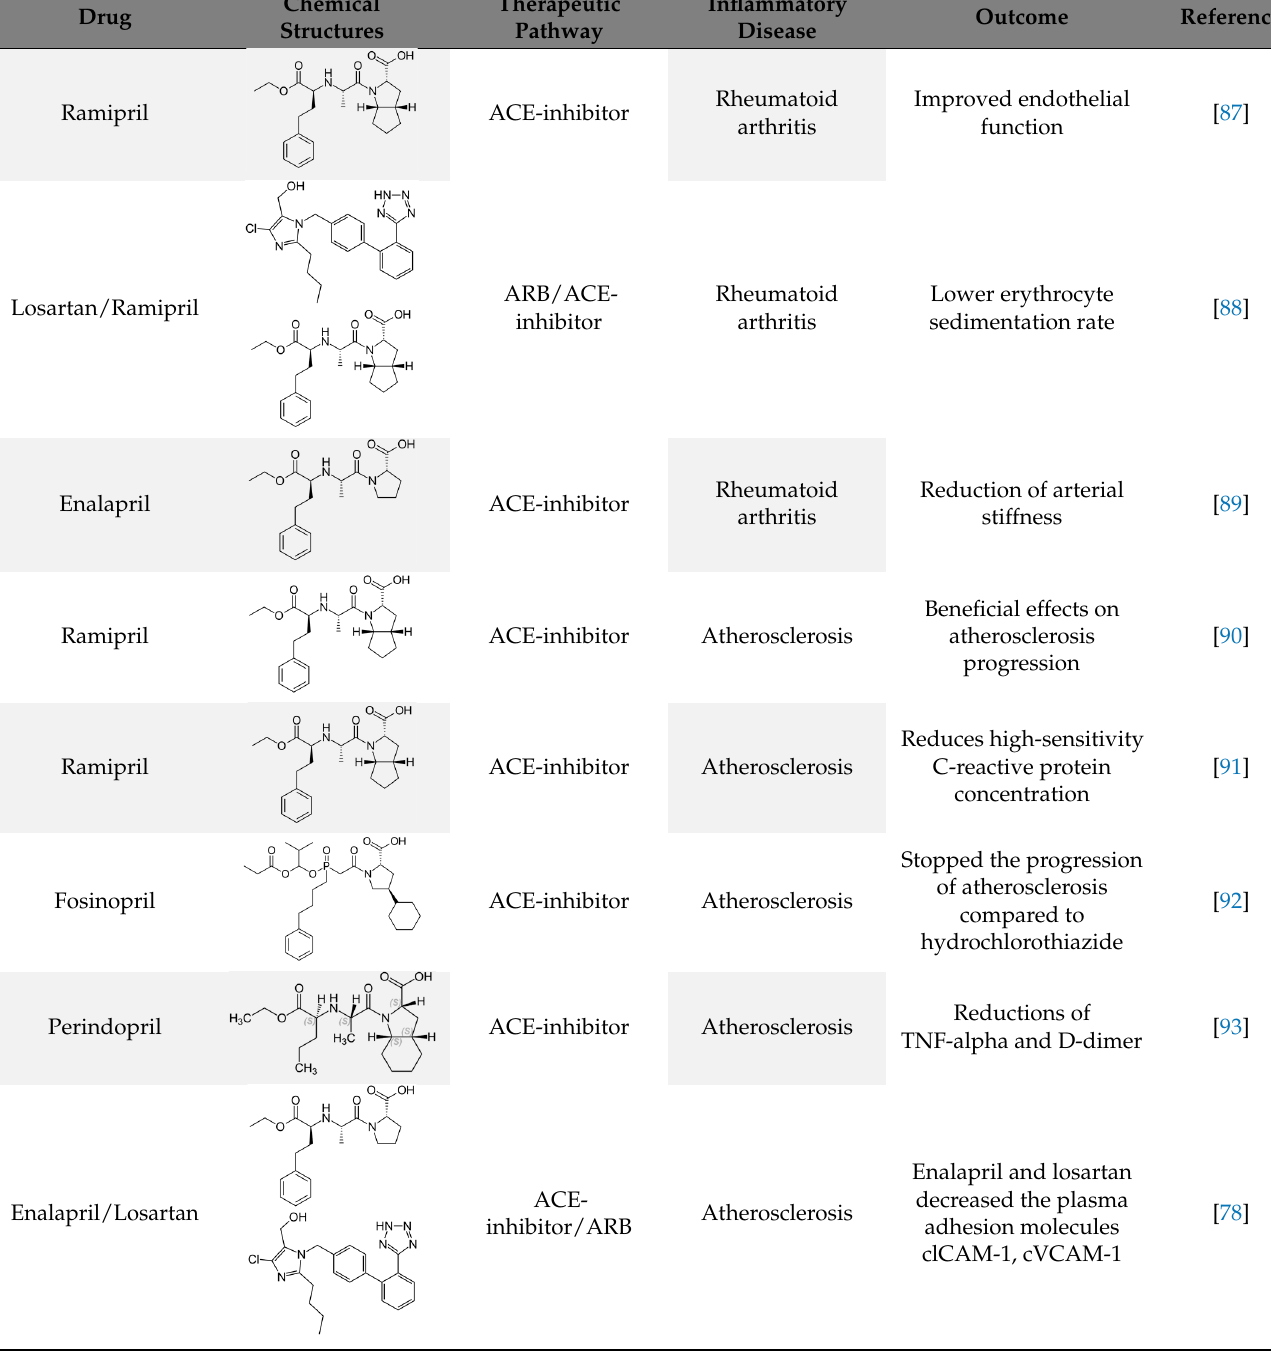
Table 1. Overview and outcomes of clinical trials on tRAS modulation in inflammatory diseases. NASH: nonalcoholic steatohepatitis; TNF ‐ alpha: tumor necrosis factor ‐ alpha; clCAM: circulating intercellular adhesion molecule ‐ 1; VCAM: vascular cell adhesion molecule; cVCAM: circulating vascular cell adhesion molecule ‐ 1; eNOS: endothelial nitric oxide synthase; NO: nitric oxide; ROS: reactive oxygen species; NF ‐ kappa β : nuclear factor ‐ kappa β ; CRP: c ‐ reactive protein; TGF ‐ beta1: transforming growth factor ‐ beta 1; Enalapril